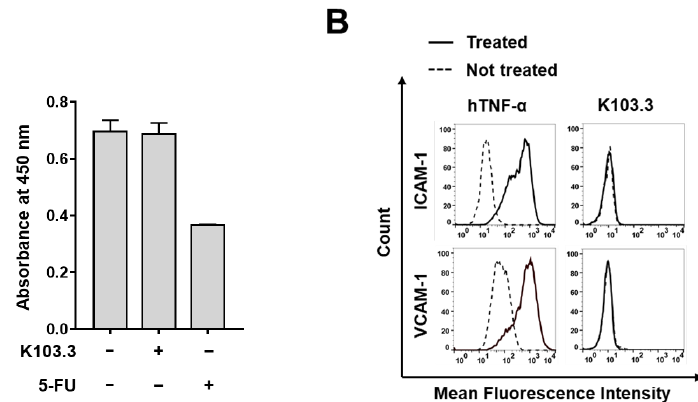
Figure 7. Effect of K103.3 on endothelial cell toxicity. ( A ) HUVECs were incubated in the absence or presence of K103.3 or 5-FU. Cell viability was measured at an absorbance of 450 nm. Values represent the mean ± SEM of triplicate measurements. ( B ) HUVECs were cultured in the presence or absence of hTNF- α or K103.3, stained with anti-ICAM-1 ( upper panel) or VCAM-1 ( lower panel) polyclonal antibody, and analyzed using flow cytometry.